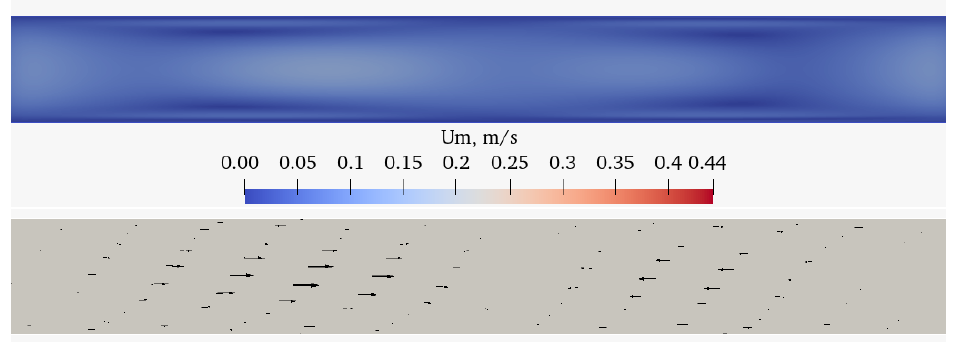
Figure 10. Velocity magnitude and vectors of streaming on the 2D cross-sections ( xy planes) of the 3D resonator for z = ( 0.5,0.375,0.125 ) W. ( a ) xy plane at z = 0.5 W. ( b ) xy plane at z = 0.375 W. ( c ) xy plane at z = 0.125 W.